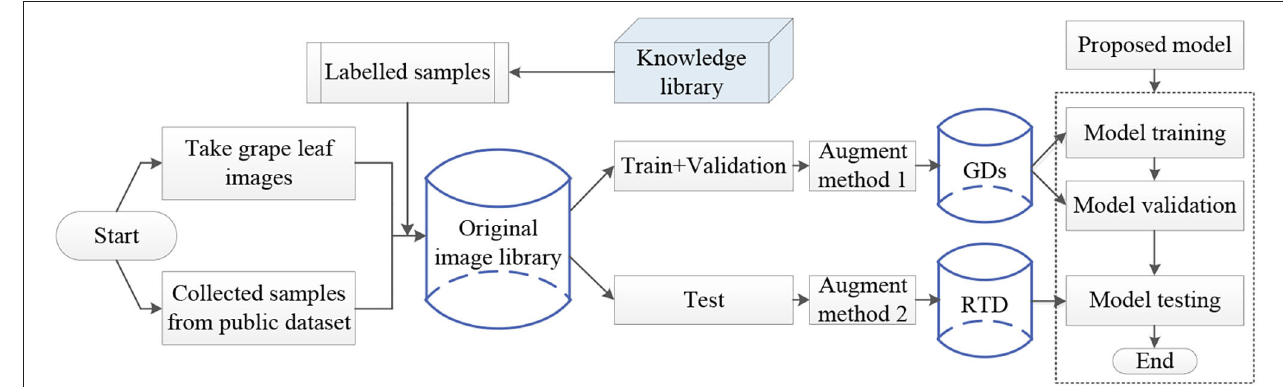
FIGURE 6 | The overall flowchart of grape fine-grained disease image